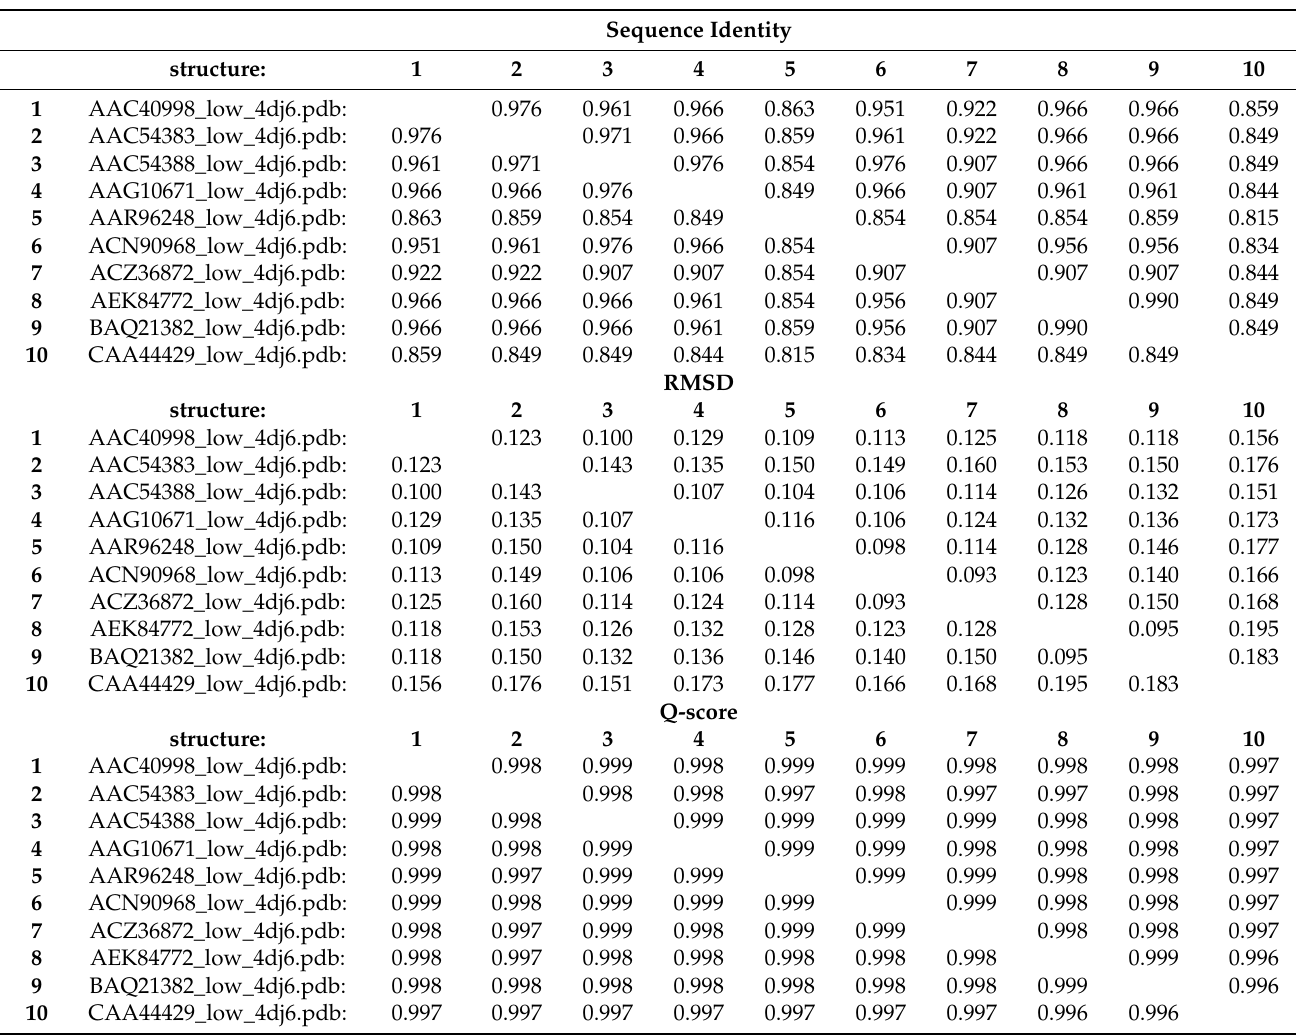
Table 1. Sequence identity, RMSD and Q-score for LPAI sequences modeled on PDB 4DJ6.